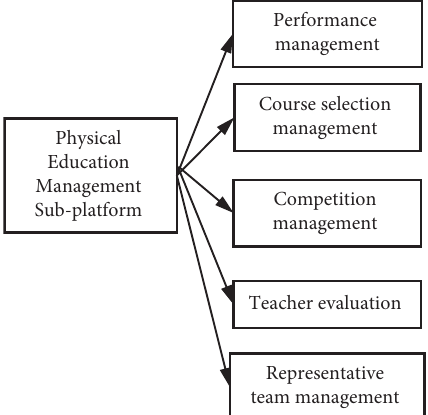
Figure 4: Framework of physical education teaching management subplatform (some